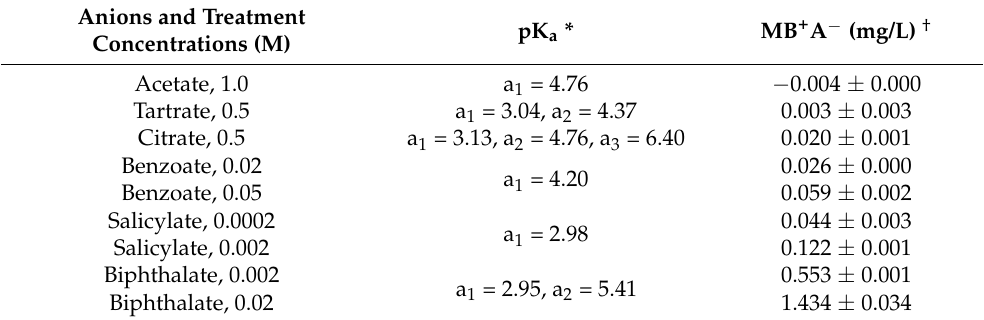
Table 5. Effect of sulfuric acid pretreatment on COO − interferences in MIBK-DCE